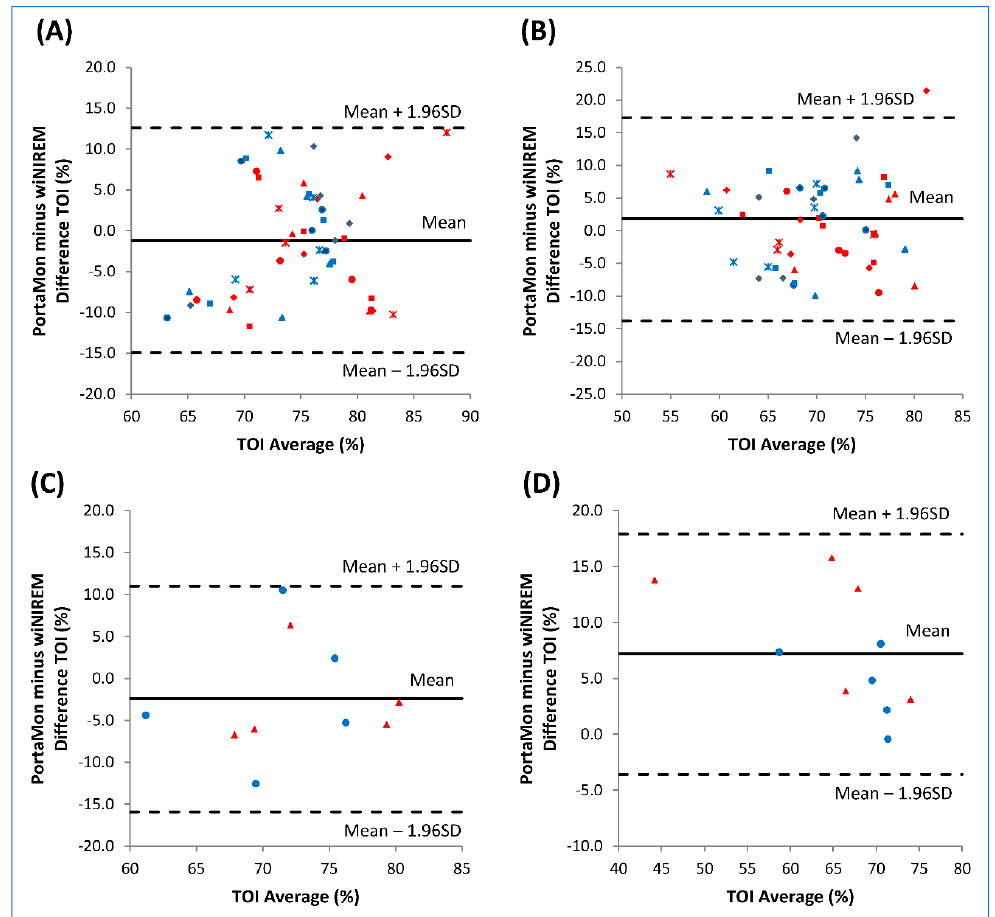
Figure 5. Bland–Altman plots of the difference of rectus femoris (RF) tissue oxygenation index (TOI, %) provided by the two oximeters (wiNIREM and PortaMon) during run (upper panels; A , B ) and dynamic high squat performed at 50% of maximal isometric voluntary contraction (lower panels; C , D ). The comparisons were performed on both legs (red: right RF; blue: left RF). Upper panels: each point was obtained averaging the TOI values of the last 20 s at rest ( A ) and the last 20 s of submaximal treadmill run at several speeds ( B ). Triangle: 4 km/h; circle: 10 km/h; square: 12 km/h; rhombus: 14 km/h; asterisk: 16 km/h. Lower panels : each point was obtained in the last repetition at rest ( C ) and during dynamic high squat performance ( D ). The upper and lower dotted horizontal lines correspond to ±1.96SD limits of agreement and the center solid line represents the bias.